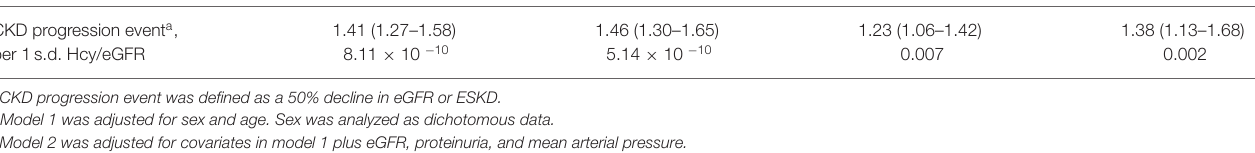
( Supplementary Figure 1 ). The area under the ROC curves (AUC) was 0.79 with the cut-off point of 0.46. Then, Kaplan- Meier curves demonstrated that patients with Hcy/eGFR ratio > 0.46 had a higher incidence of the composite kidney disease progression event (log-rank test, p < 0.001) ( Figure 3A